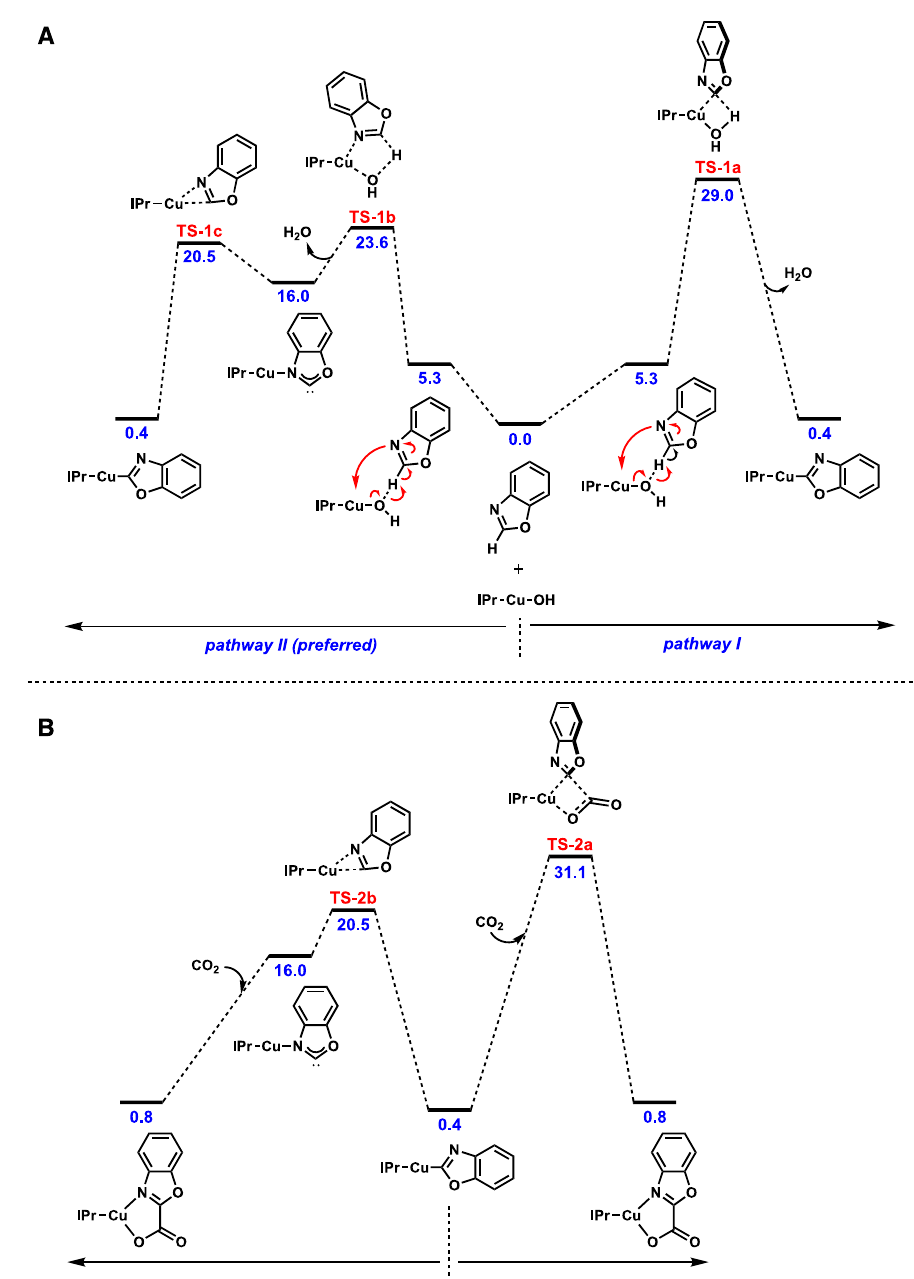
Figure 5. ( A ) Computed energy profiles for two possible pathways for the protonolysis of [Cu(IPr)(OH)] by benzoxazole determined via density functional theory (DFT). ( B ) Computed energy profiles for two possible CO 2 activation pathways from a copper benzoxazolyl complex determined via DFT. The relative free energies are given in kcal/mol.